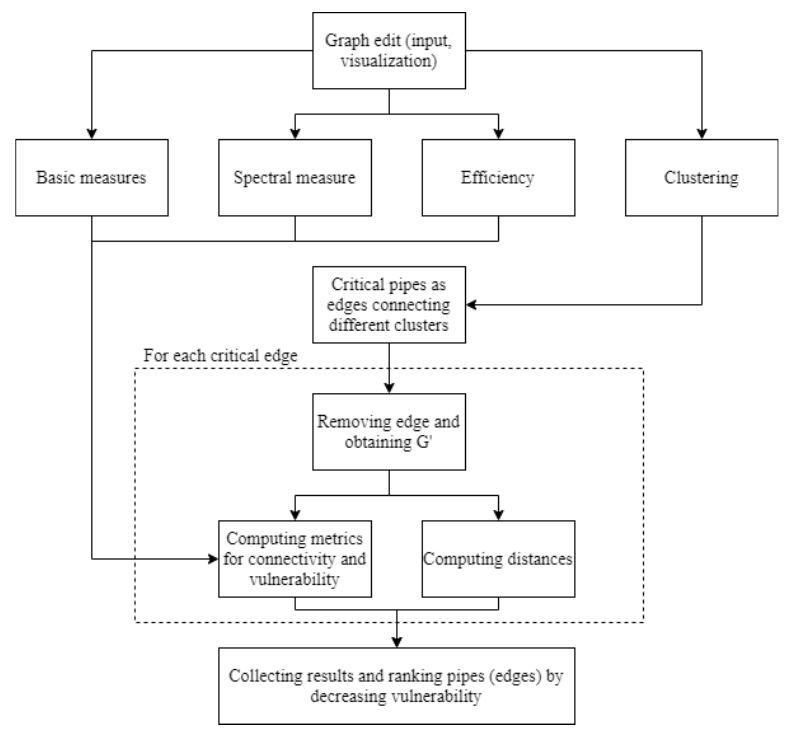
Figure 8. Analysis framework.